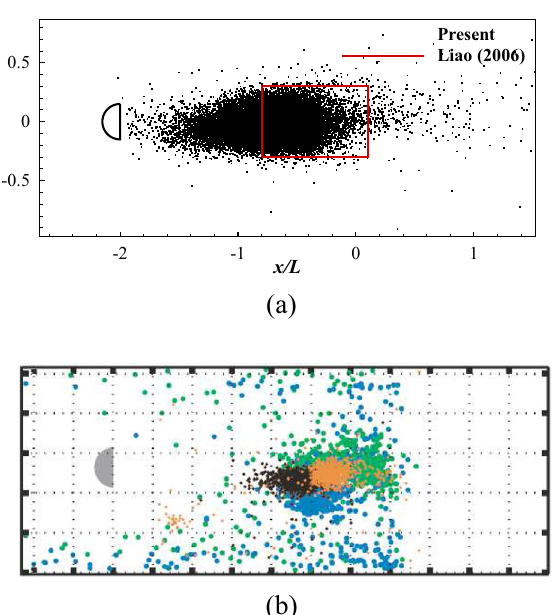
Figure 17. The location of the swimmer swimming in a Kármán vortex street: ( a ) the current result, and ( b ) the experimental observation in Ref. 50 .